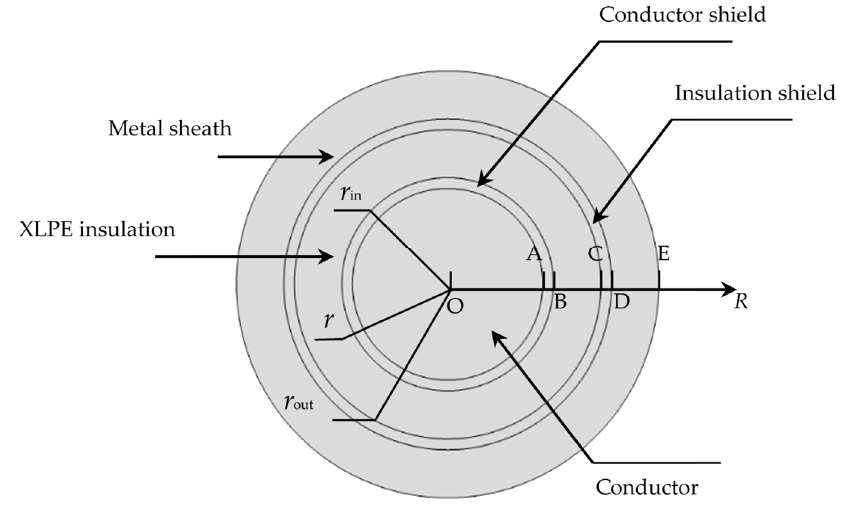
Figure 1. Geometric configuration.